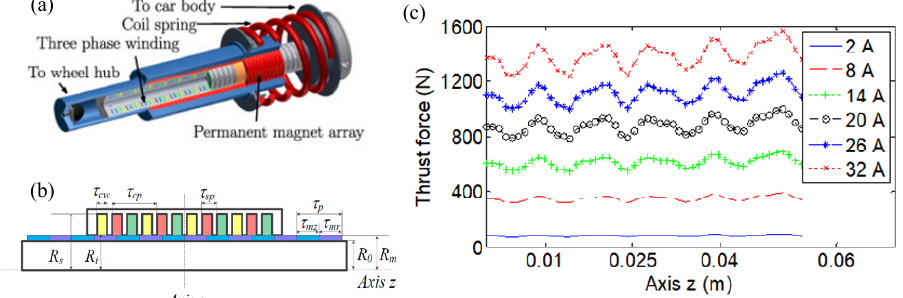
Figure 6. ( a ) Electromagnetic suspension system; ( b ) linear motor actuator structure; ( c ) thrust force according to axial